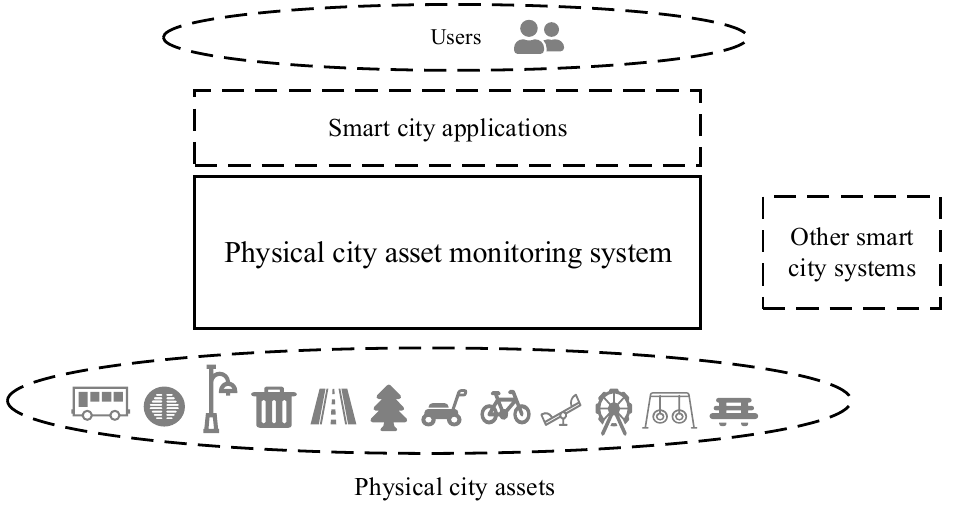
Figure 3. Overview diagram for physical city asset monitoring system.